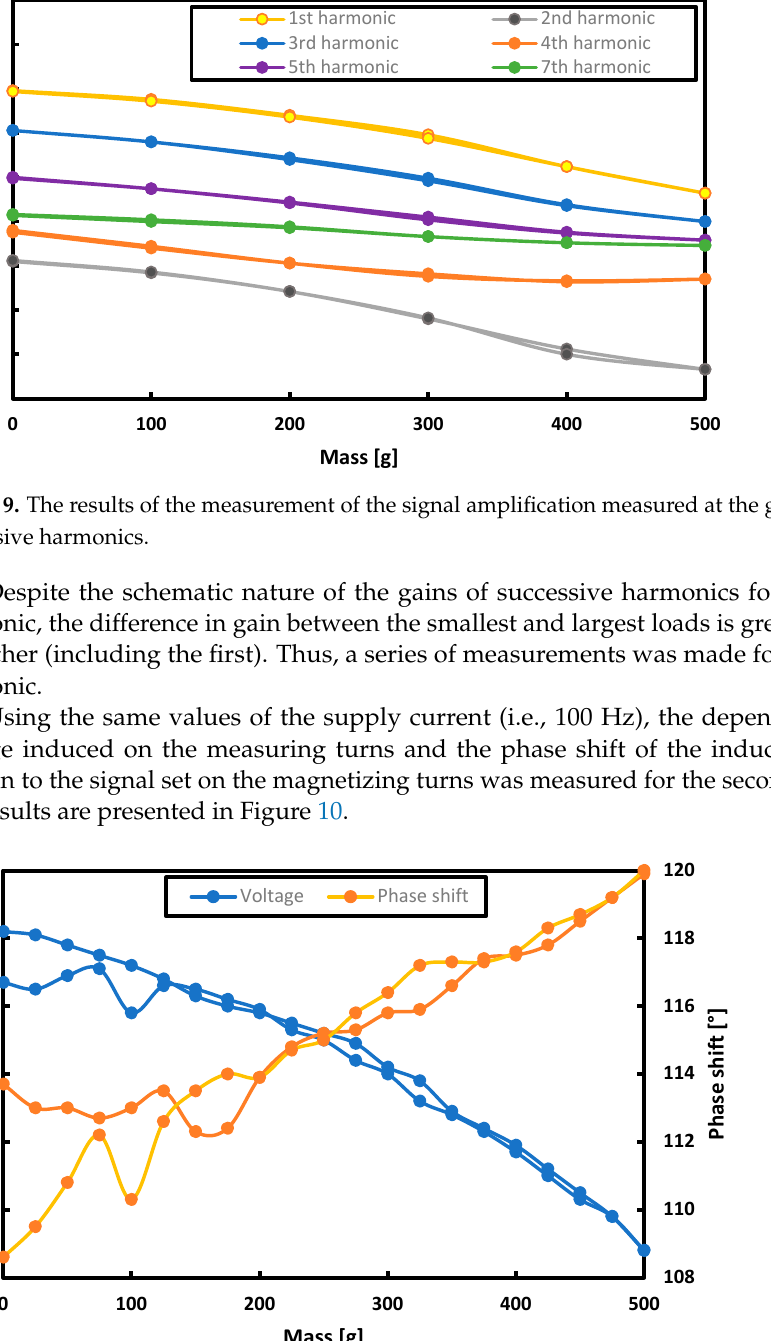
Figure 10. Measurement results of the voltage induced on the measuring coils and the phase shift of the measured signal against the set one in the second harmonic for different masses loading the plate.